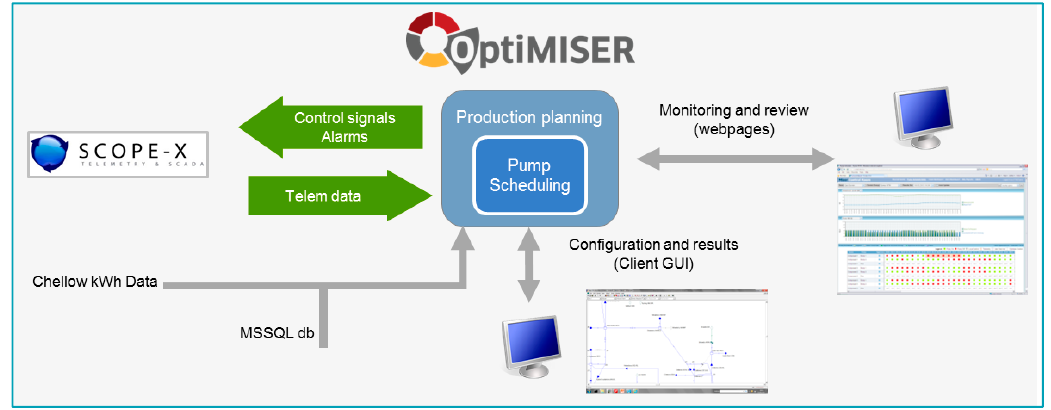
Figure 3. OptiMISER Context